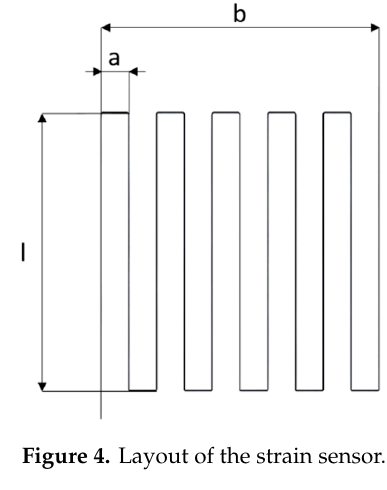
Figure 4. Layout of the strain sensor.